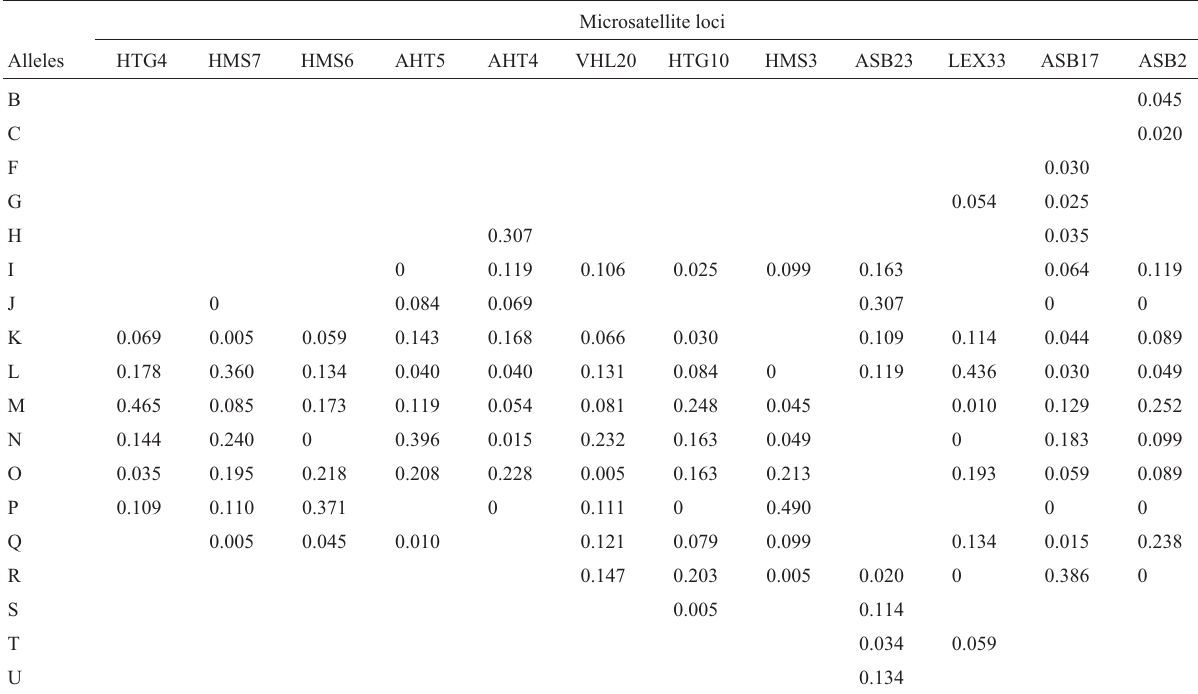
Table 1 - Allele frequencies of microsatellite DNA polymorphisms in a sample of Pantaneiro